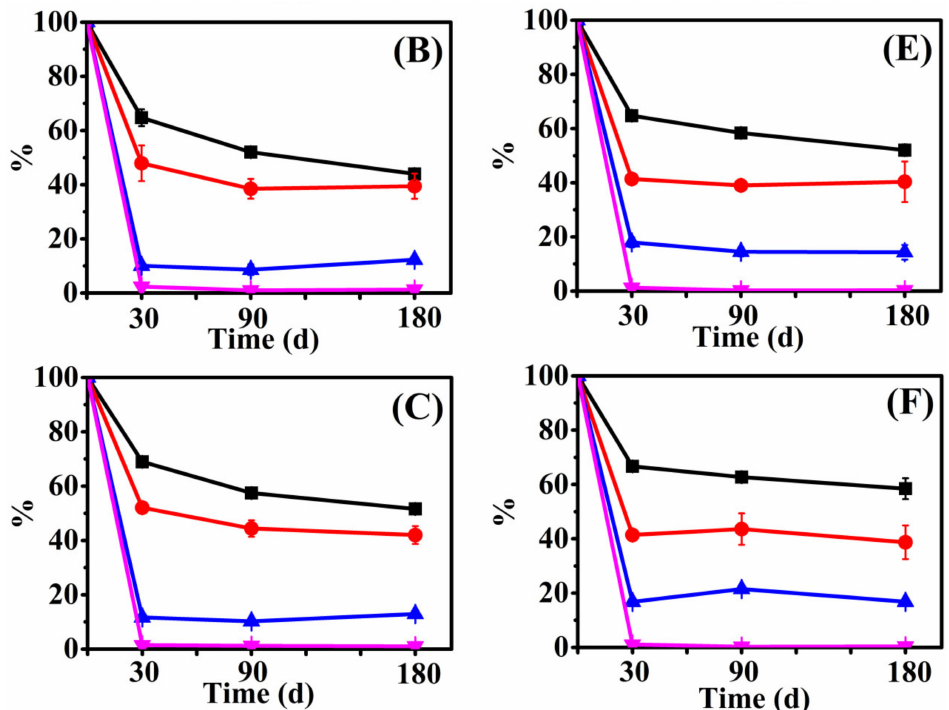
Figure 3. Carbon, nitrogen, phosphorus, and potassium NAI values of E. crusgali and B. tripartita litter decomposition after 30, 90, 180 days at 0, 5, 10 cm burial depths under flooding. ( A ) E. crusgali at 0 cm; ( B ) E. crusgali at 5 cm; ( C ) E. crusgali at 10 cm; ( D ) B. tripartita at 0 cm; ( E ) B. tripartita at 5 cm; ( F ) B. tripartita at 10 cm. NAI: nutrient accumulation index. NAI values are expressed relative to the initial litter mass. Error bars indicate ± 1 S.E.